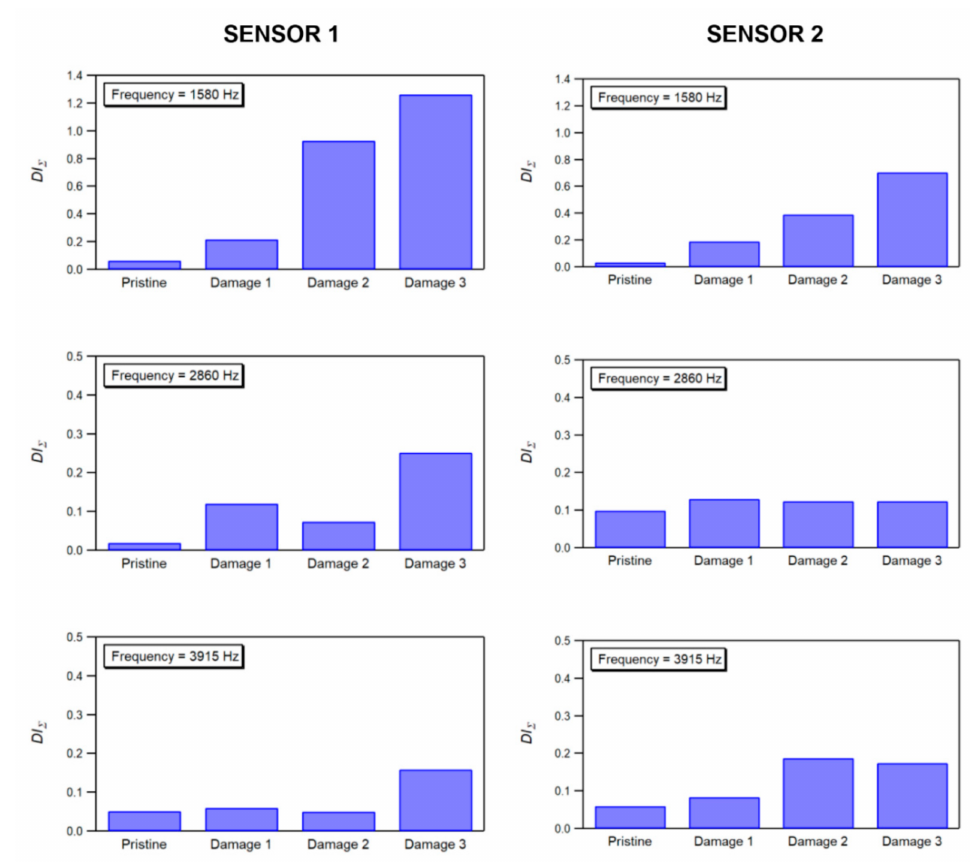
Figure 8. Pulse excitation: values of the damage index DI S calculated for the different spectral frequencies at increasing damage severities.